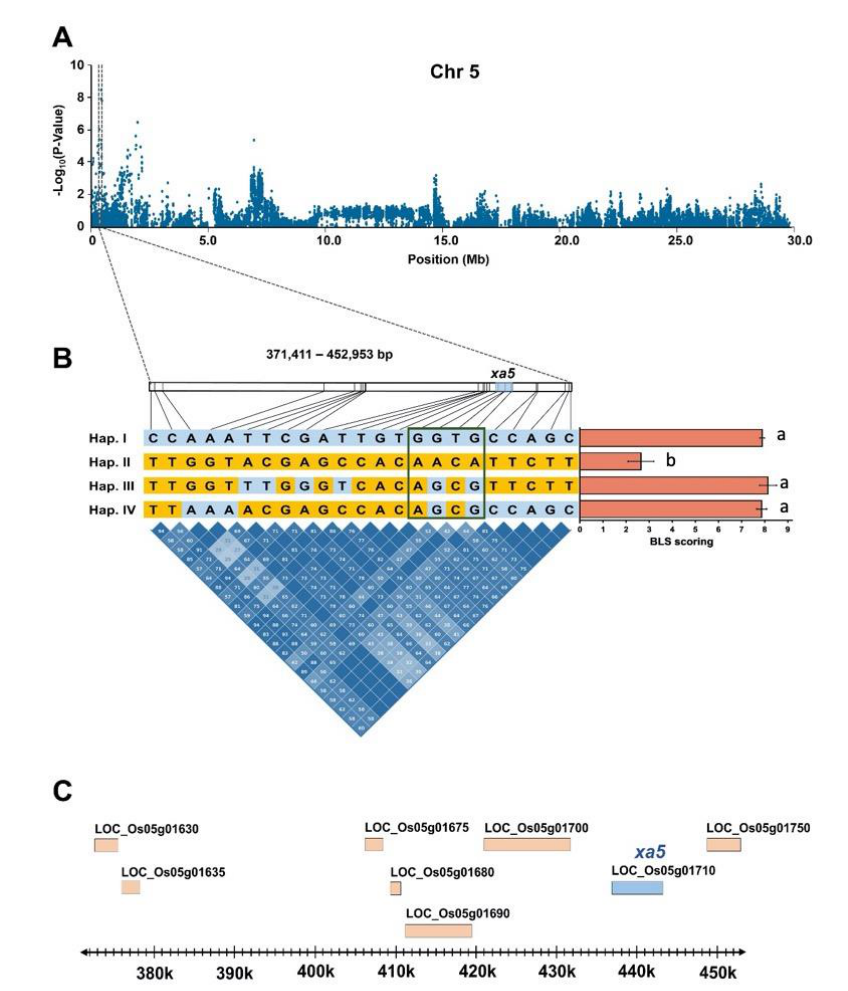
Figure 5. Identification of the candidate gene for the peak of qBLS5.1 on chromosome 5. ( A ) Manhattan plot on chromosome 5 based on mixed-linear Model (MLM). X-axis shows the SNPs along the chromosome and y-axis is the –log10 ( p ) for the association. The peak region is indicated in the block between two vertical dotted lines. ( B ) Haplotype block and LD focusing on four SNPs on xa5 gene inside the green block. The bar graph is shown the average BLS scoring. X-axis is the disease scoring scale 0–9 (0 = resistance, 9 = susceptible) and y-axis is showed the haplotype. Letters to the right most of the bar graph indicate significant groups. Color codes for nucleotides in the haplotypes: yellow represents minor alleles and blue represents major alleles. ( C ) Significant SNP position overlapping the region of xa5 gene ( LOC_Os05g01710 ).